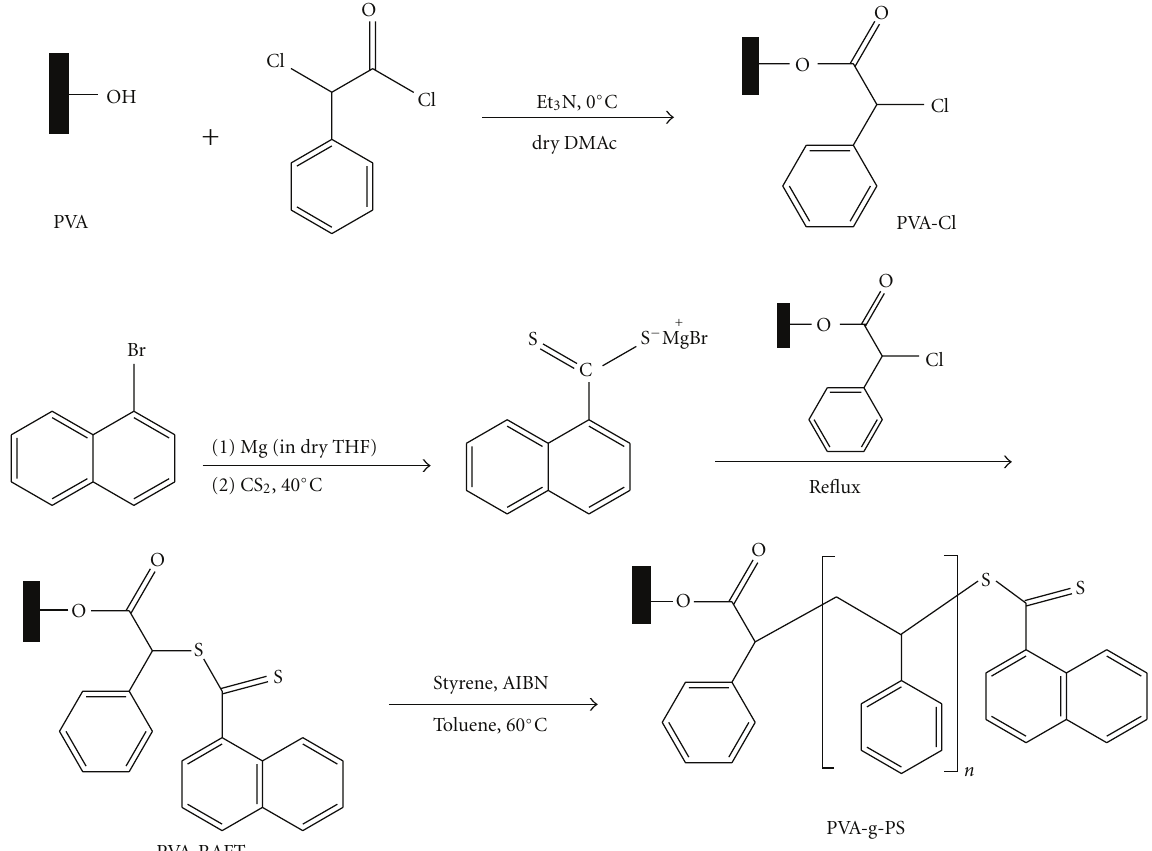
Scheme 1: The synthesis pathway to PVA-g-PS via RAFT process.